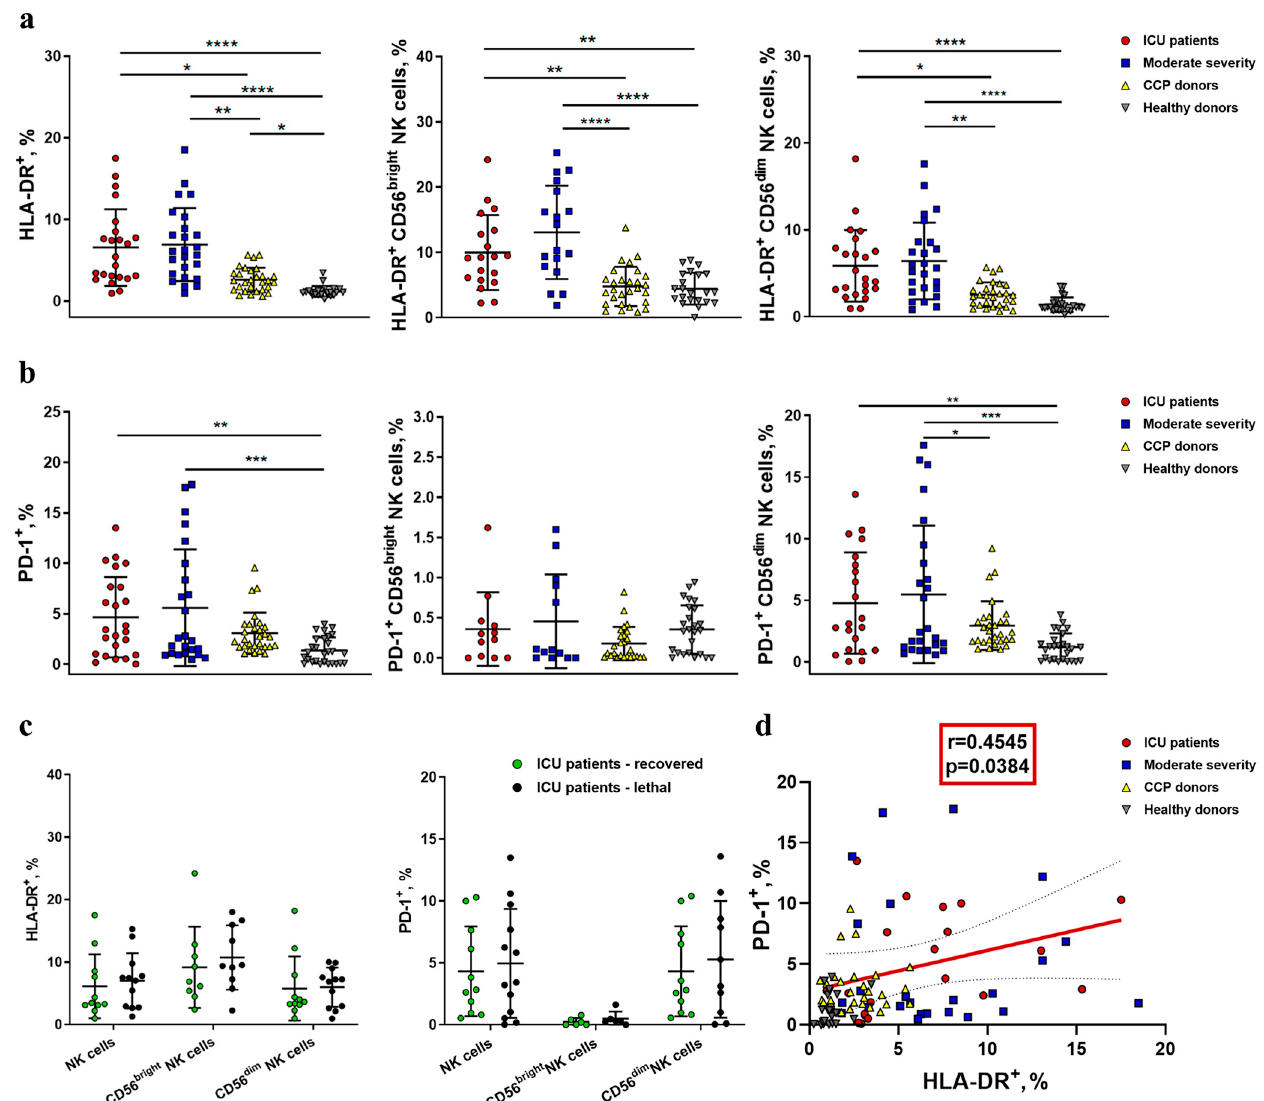
Figure 4. Analysis of activation and exhaustion markers in NK cells from COVID-19 patients, convalescent patients, and healthy donors. ( a ) The proportion of HLA-DR + cells among NK cells and CD56 bright and CD56 dim subsets in the following comparison groups: ICU patients (n = 23), moderate-severity patients (n = 25), CCP donors (n = 29), and healthy donors (n = 24). ( b ) The proportion of PD-1 + cells among NK cells and CD56 bright and CD56 dim subsets in the following comparison groups: ICU patients (n = 31), moderate-severity patients (n = 25), CCP donors (n = 29), and healthy donors (n = 28). ( c ) Comparative analysis of HLA-DR + and PD-1 + cell percentages among NK cells and CD56 bright and CD56 dim subsets in recovered and lethal ICU patients from ICU group. ( d ) Spearman correlation between HLA-DR and PD-1 expression in all donor groups. ( a – c ) Data are presented as individual values with mean (±SD). * p < 0.05, ** p < 0.01, *** p < 0.001, **** p < 0.0001.